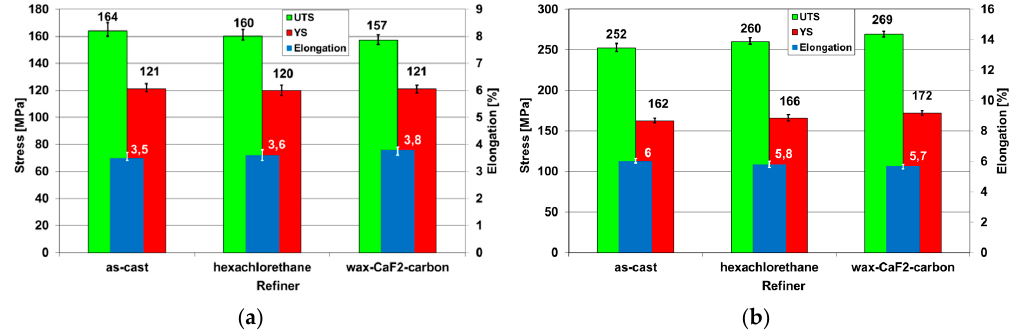
Figure 9. Influence of modifiers on mechanical properties of AZ91 alloy: ( a ) as-cast, ( b ) heat-treated.